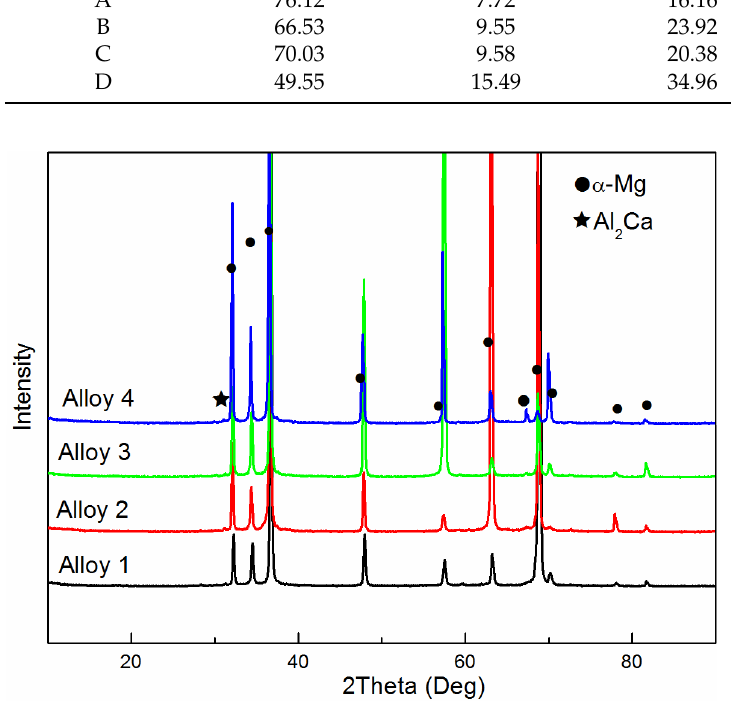
Figure 3. Calculated Mg-2Al-xCa (x, 0–1 wt.%) phase diagram using Pandat. 3.2. Microstructures of the As-Extruded Alloy The OM images of the as-extruded sheet samples in the ED–TD plane are shown in Figure 4, where ED is the extrusion direction and TD is the transverse direction. It can be seen that all the as-extruded sheets show complete equiaxed DRXed grains. The average grain size of as-extruded Zn-contained alloys is refined compared to Zn-free alloys. In addition, many second phases are observed in the SEM images (seen in Figure 5), where these second phases distribute along the extrusion direction of the as-extruded samples. According to the EDS results (Table 3) and XRD analysis (Figure 6), these second phases are Al 2 Ca, which are the intermetallic phases and are broken up into particles during the extrusion process.